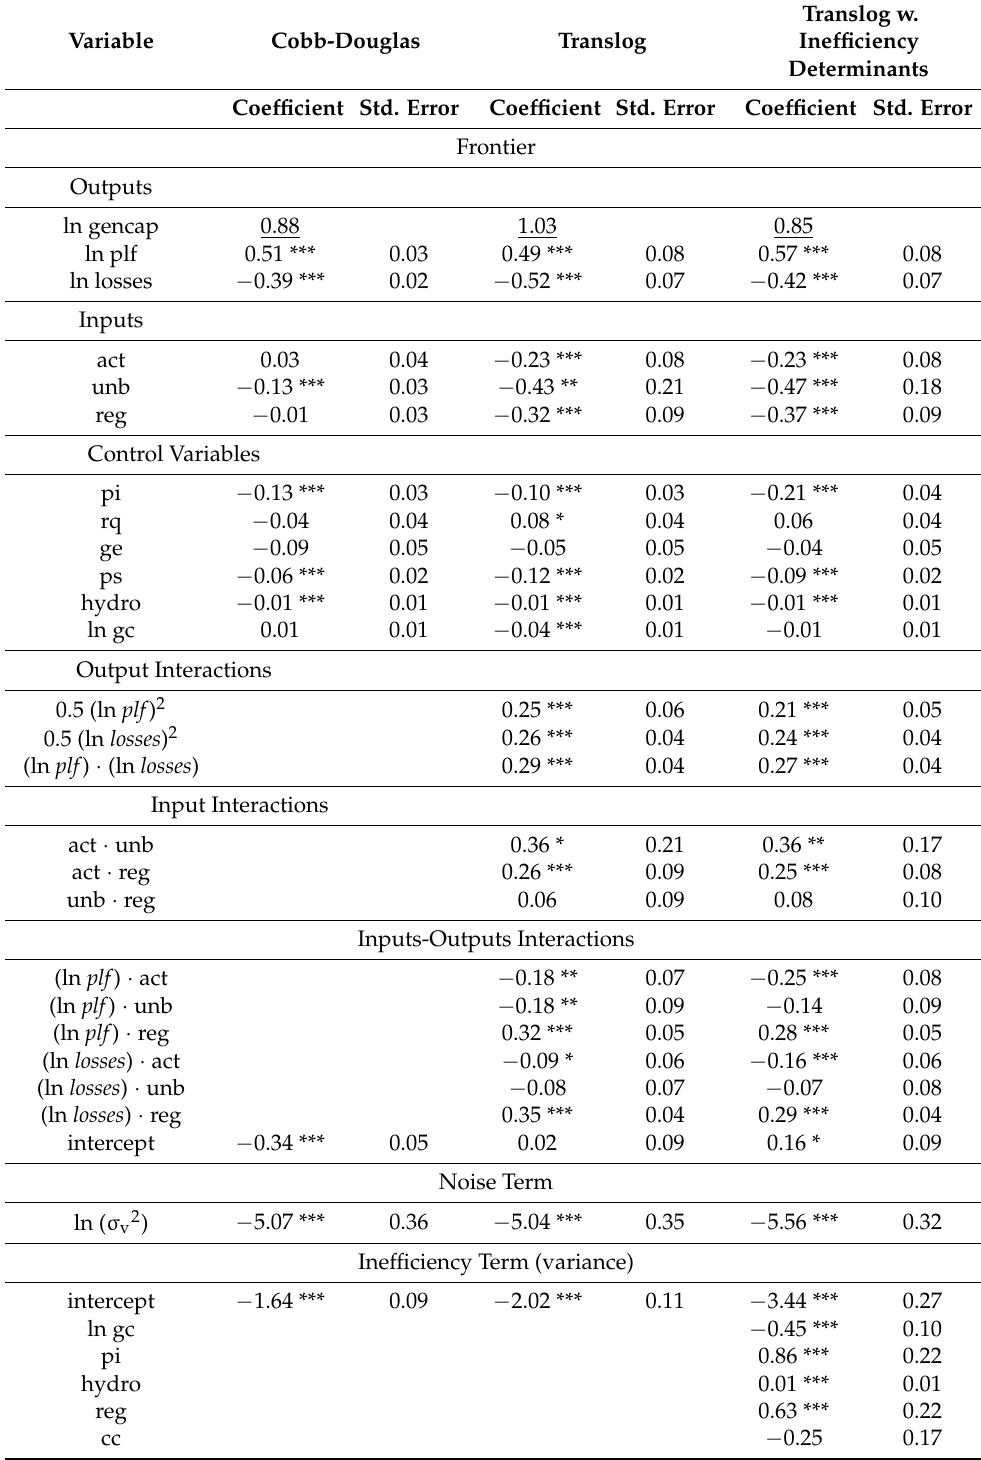
Table 4. Parameter